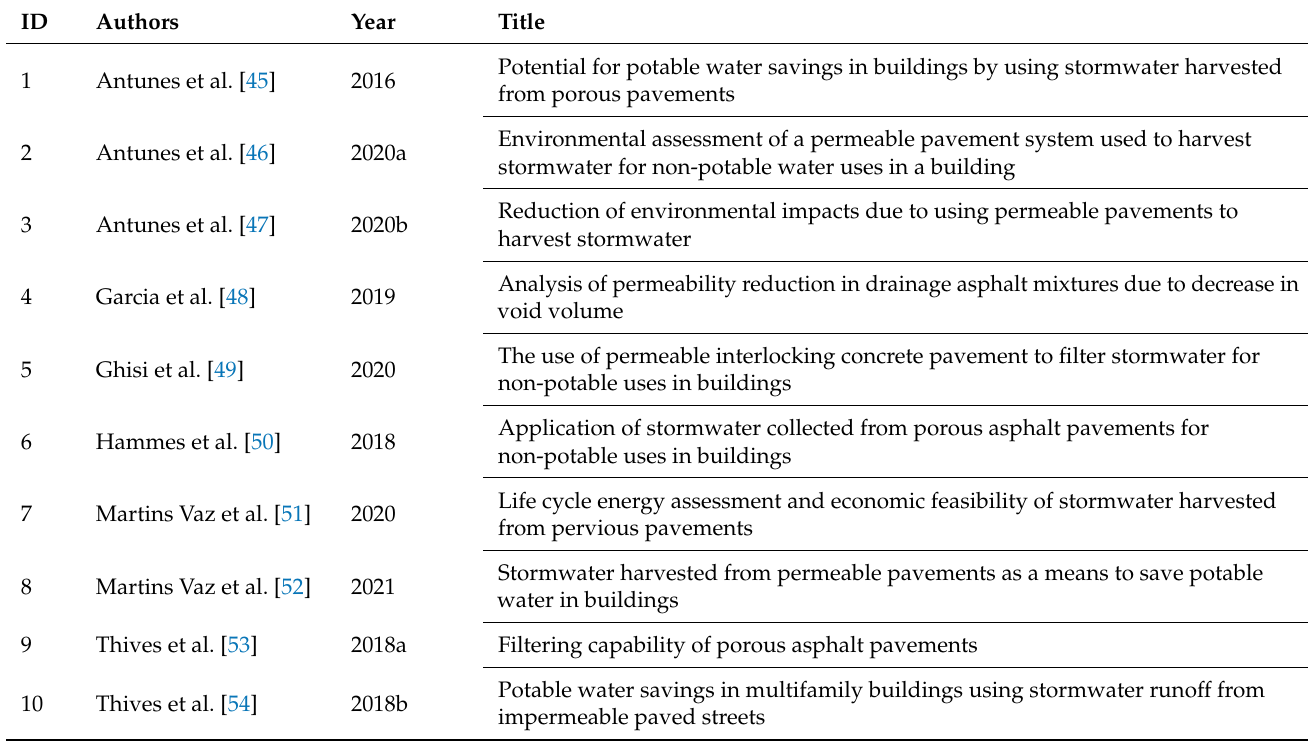
Table 1. List of selected papers.